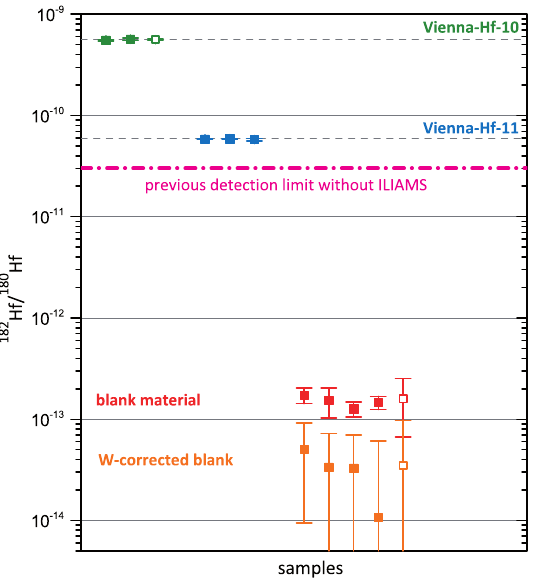
Figure 5. AMS measurement results for samples with Vienna- Hf-10 and Vienna-Hf-11 reference materials with nominal ra- tios of 182 Hf / 180 Hf = 5.59 10  10 and 182 Hf / 180 Hf = 5.88 10  11 , ⇥ ⇥ respectively, as well as blank material from commercial HfF 4 containing no 182 Hf. All results have been normalized to the Vienna-Hf-10 reference material. Filled symbols indicate that PbF 2 was admixed to the sample matrix by weight 1:1 to HfF 4 , open symbols indicate no addition of PbF 2 . Each datapoint is the average of one sputter target over multiple 10  11 and a ⇥